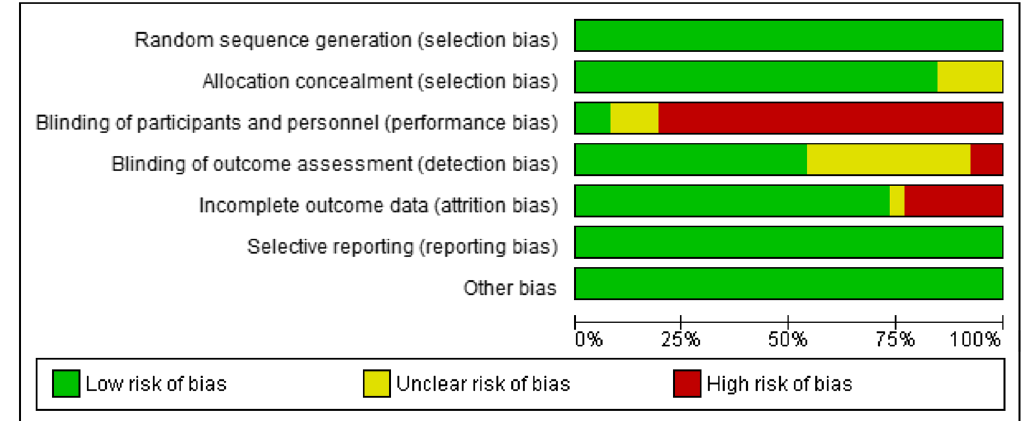
Figure 3. Risk of bias graph: review authors’ judgements about each risk of bias item presented as percentages across all included studies.